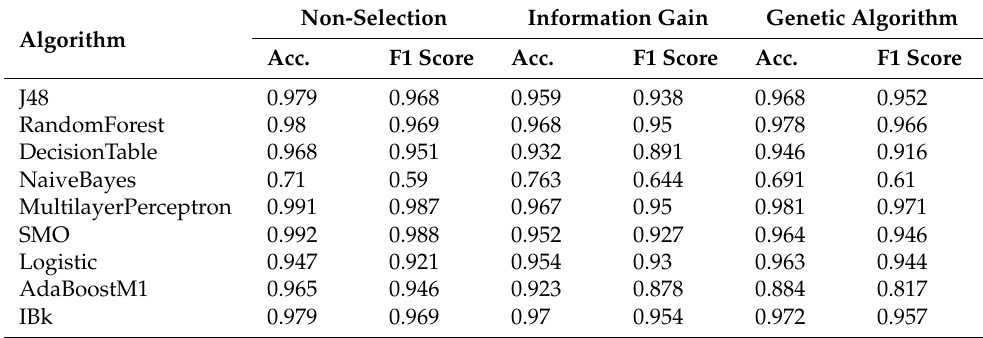
Table 4. Accuracy/F1 score performance results using the various feature selection methods.